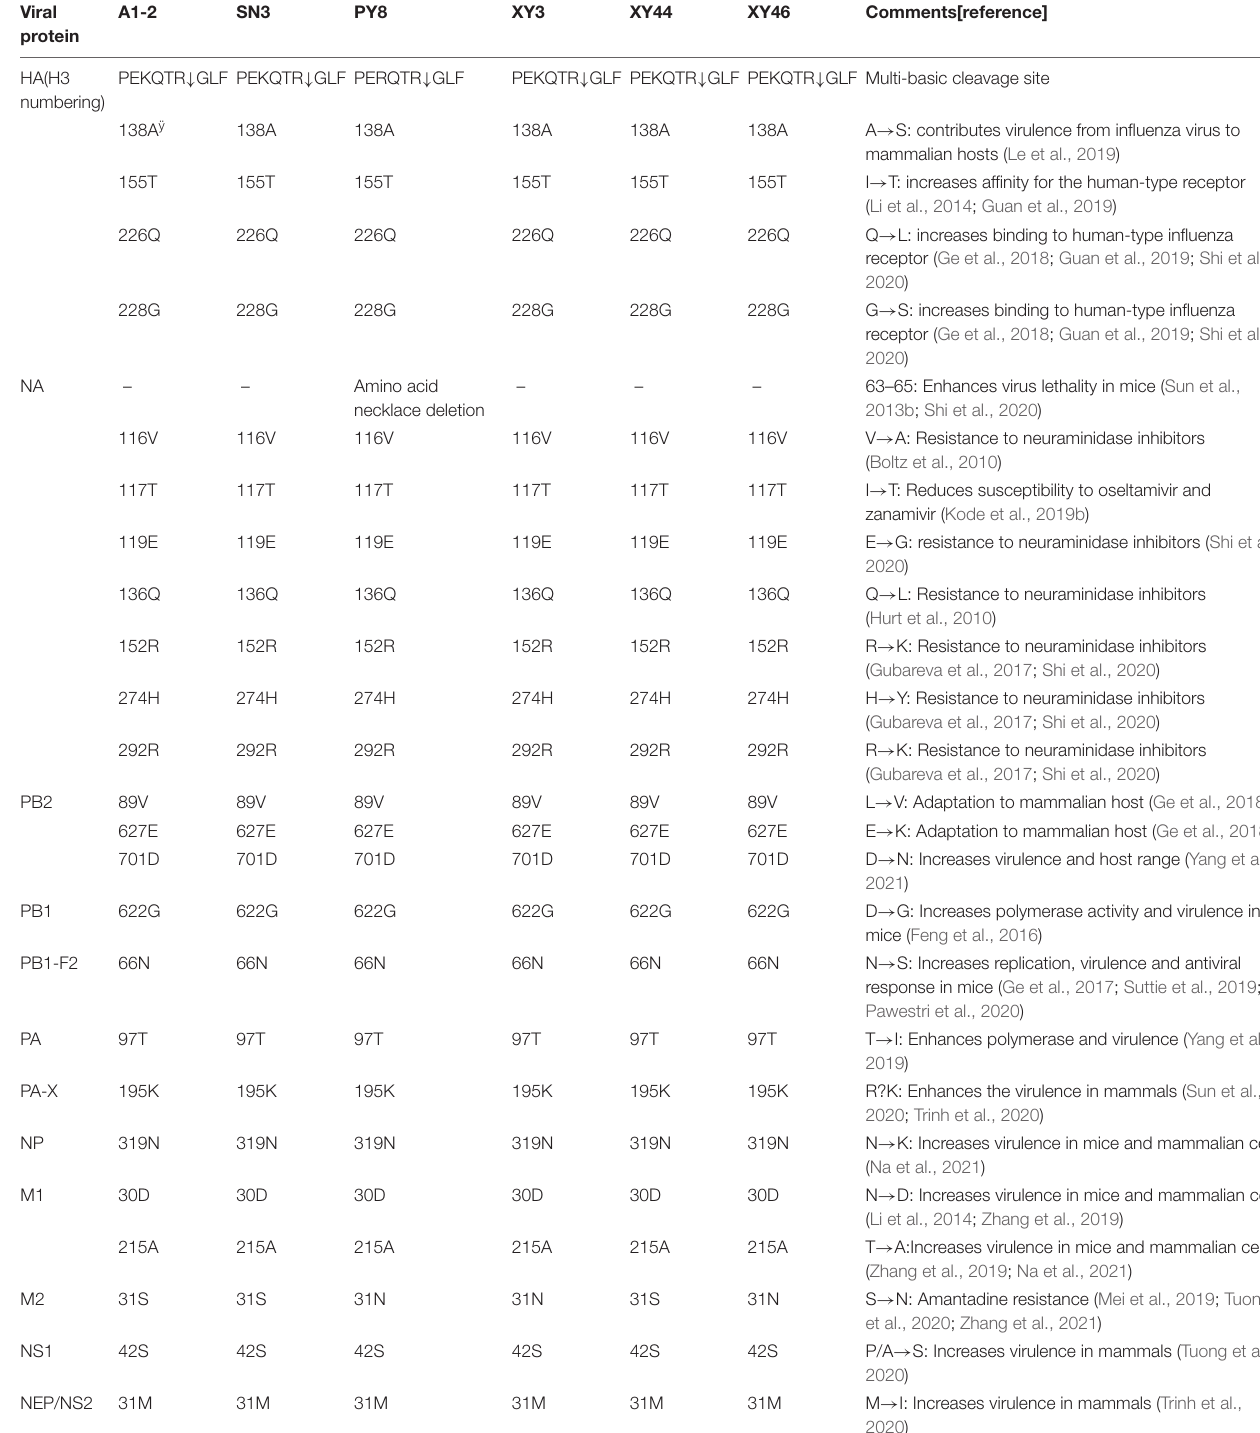
TABLE 3 | Molecular characterization of six isolates presented in this study. Viral A1-2 SN3 PY8 XY3 protein